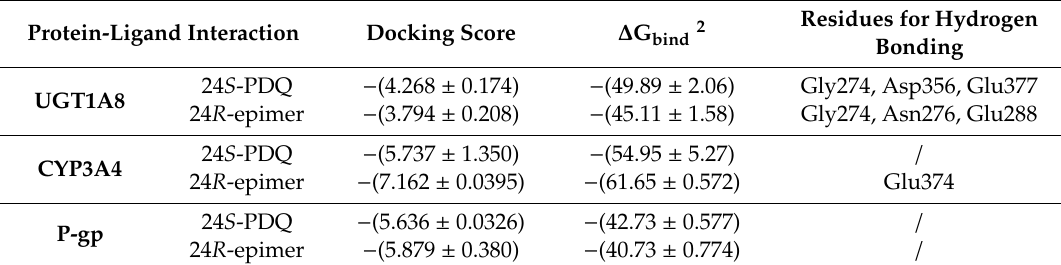
Residues for Hydrogen Bonding